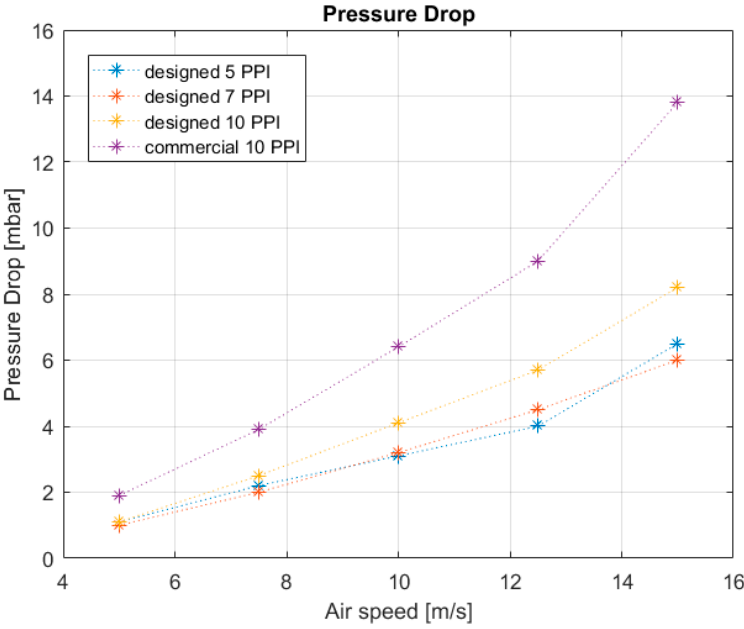
Figure 9. Pressure drop versus air speed of specific typology and comparison between the different models.